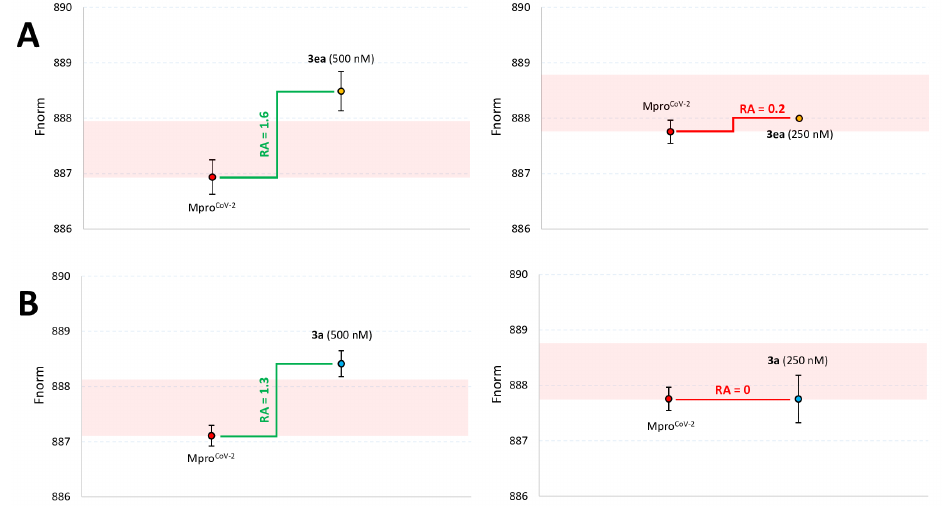
Figure 4. MST binding check experiments of ( A ) 3ea and ( B ) 3a tested at the concentration of 500 and 250 nM, respectively. In red is highlighted the “no binding” F norm area due to an insufficient Response Amplitude (RA).